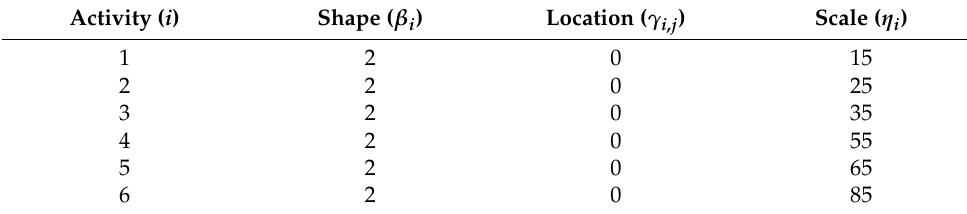
Table 2. Weibull parameters.